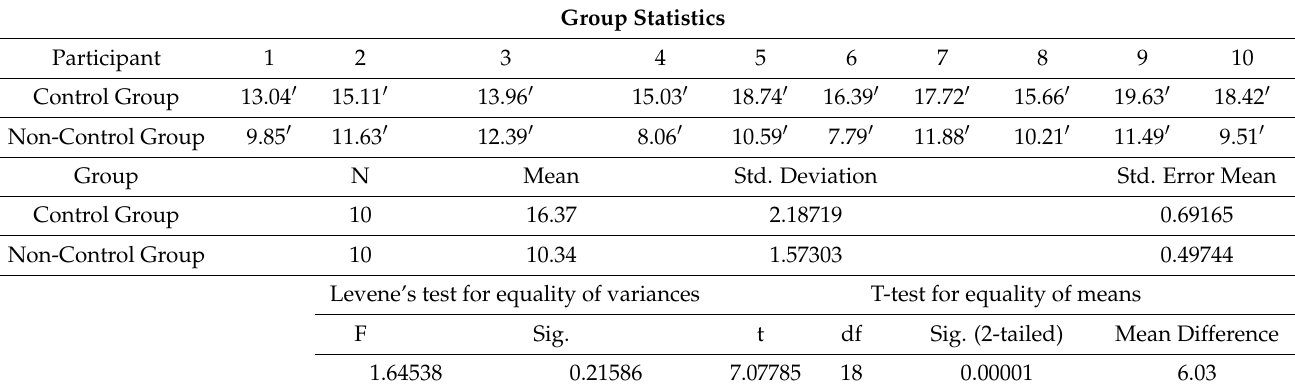
Table 4. Group statistics and independent sample test for task completion